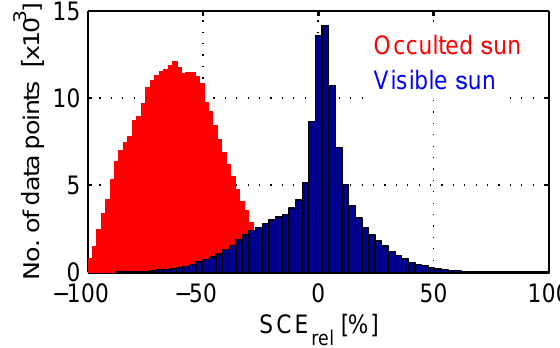
Figure 7. Dependence of the LCE on cloud-base height (CBH) for Payerne and linear regression lines of the following measured IWV ranges: red: < 5mm, green: 10–15mm, blue: 20–25mm and black: > 30mm.